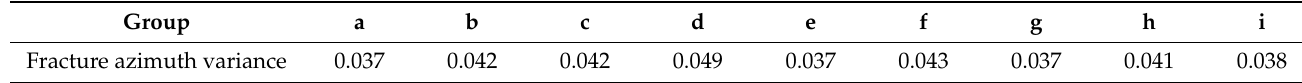
Table 5. Parallel test crack angle variance.